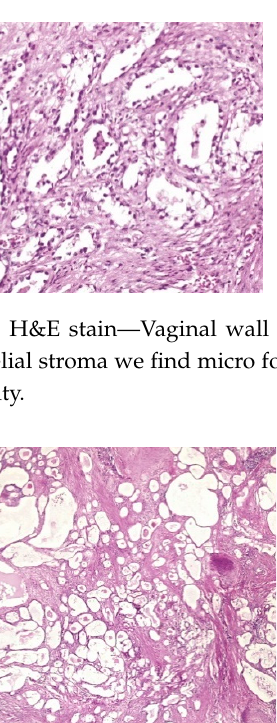
Figure 3. H&E stain—Trachelectomy specimen—Uterine isthmus—endocervix—upper limit of resection with benign mesonephric hyperplasia with areas of atypical mesonephric hyperplasia, showing moderate atypia.